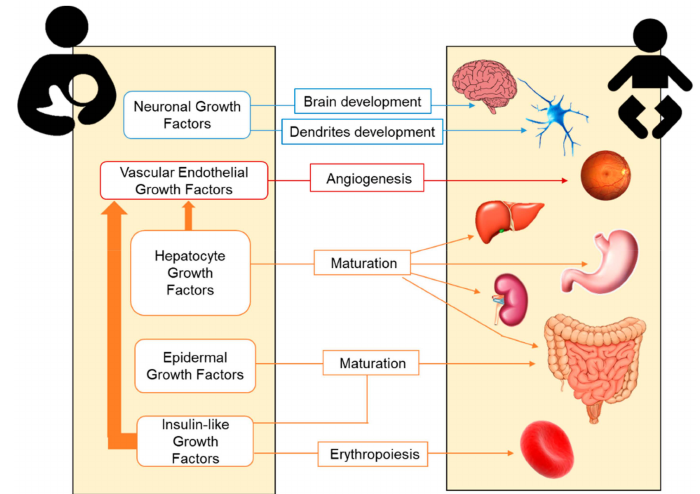
Figure 1. Transference of maternal growth factors through breastmilk and their trophic e ff ects on the growth and maturation of neonatal organs and